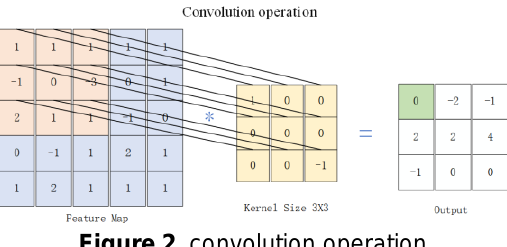
Figure 2. convolution